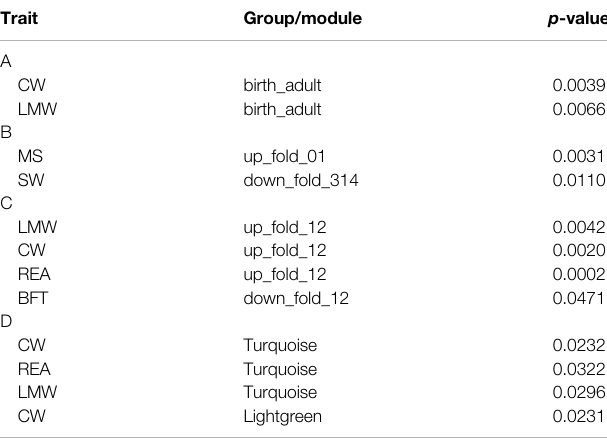
TABLE 4 | The GWAS enrichment for DEGs in different groups and modules. Trait